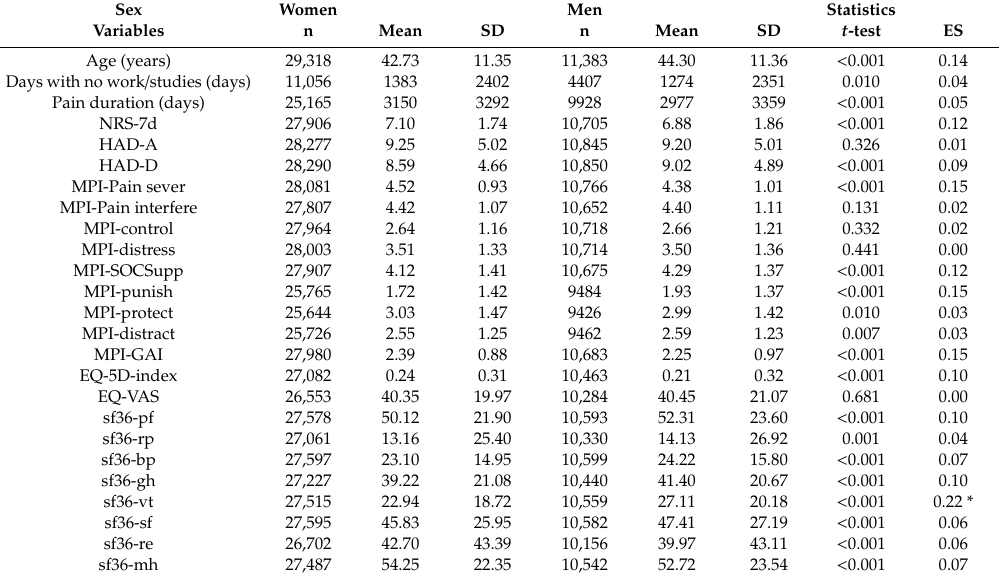
Table 1. Background and baseline data for variables used in the repeated analyses for all subjects by sex (Mean ± SD, together with n) in the total Swedish Quality Registry for Pain Rehabilitation (SQRP) database. Note that a subgroup of these patients participated in the IMMRP. Group comparison ( t -test) and e ff ect size (ES; Hedges’g) are to the far right.